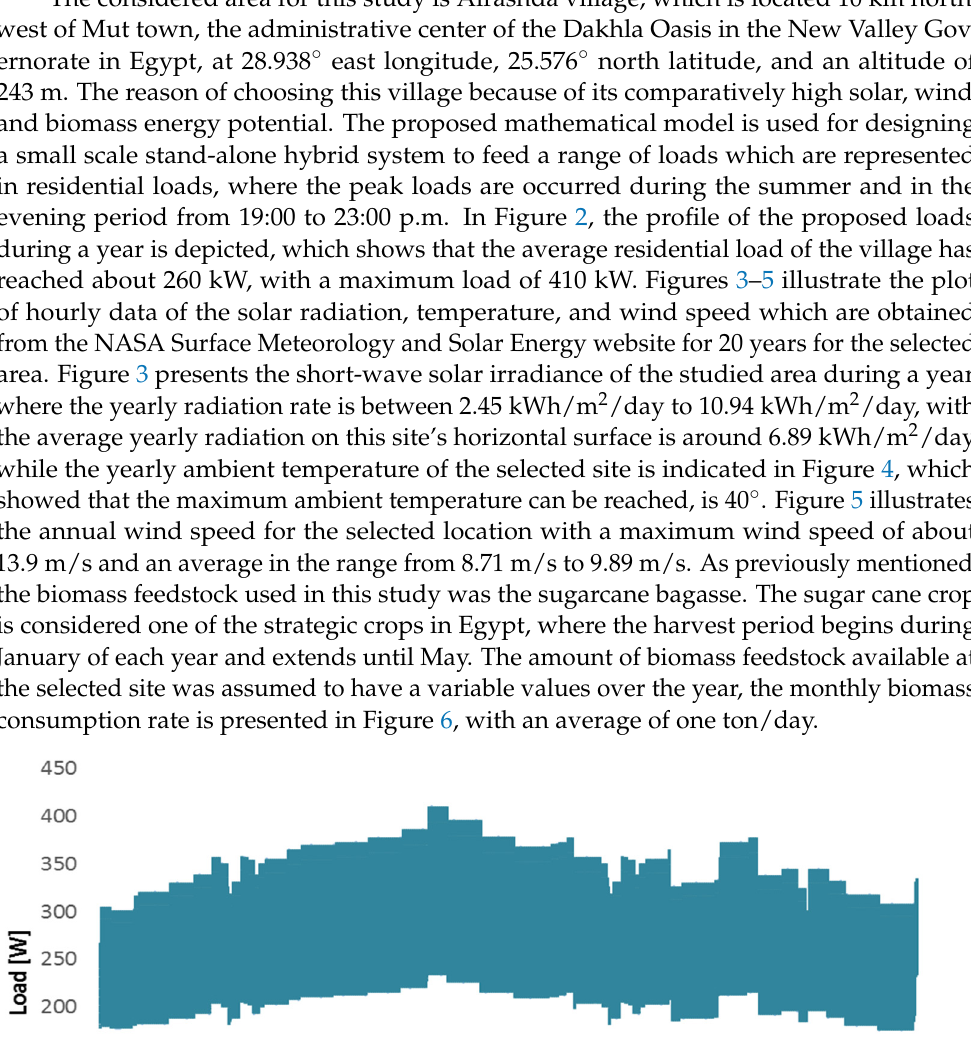
Figure 3. T he annual short-wave solar irradiance of the studied area.